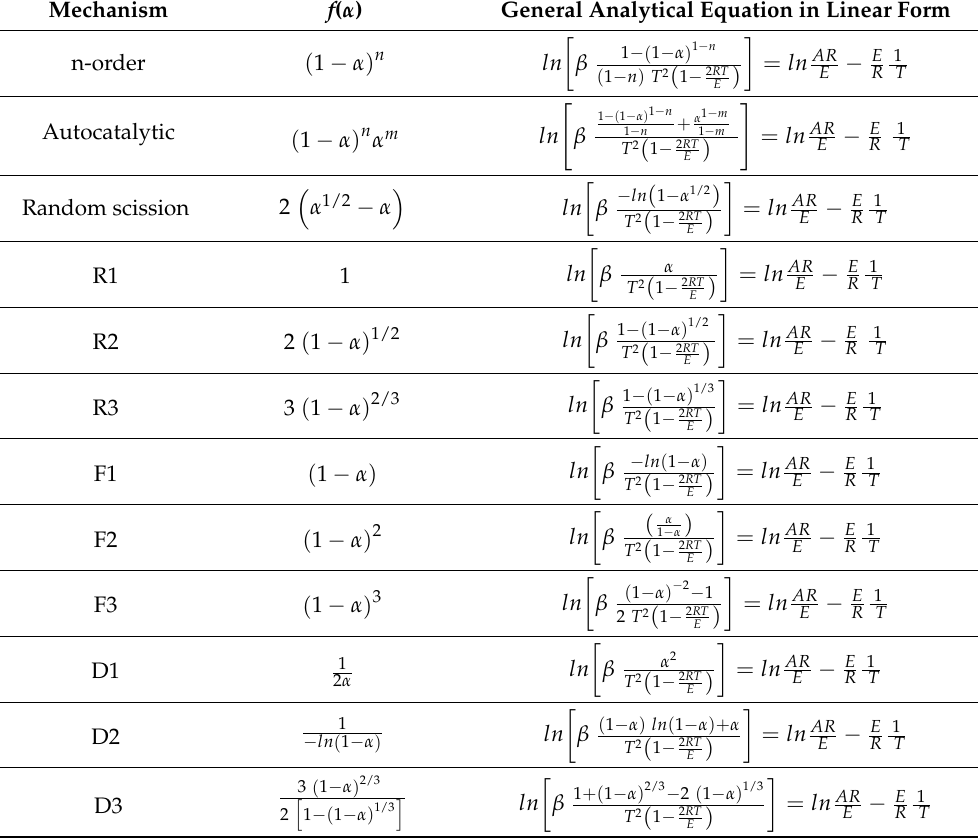
Table 1. Integral kinetic equations for various solid-state mechanisms. Mechanism f ( α ) General Analytical Equation in Linear